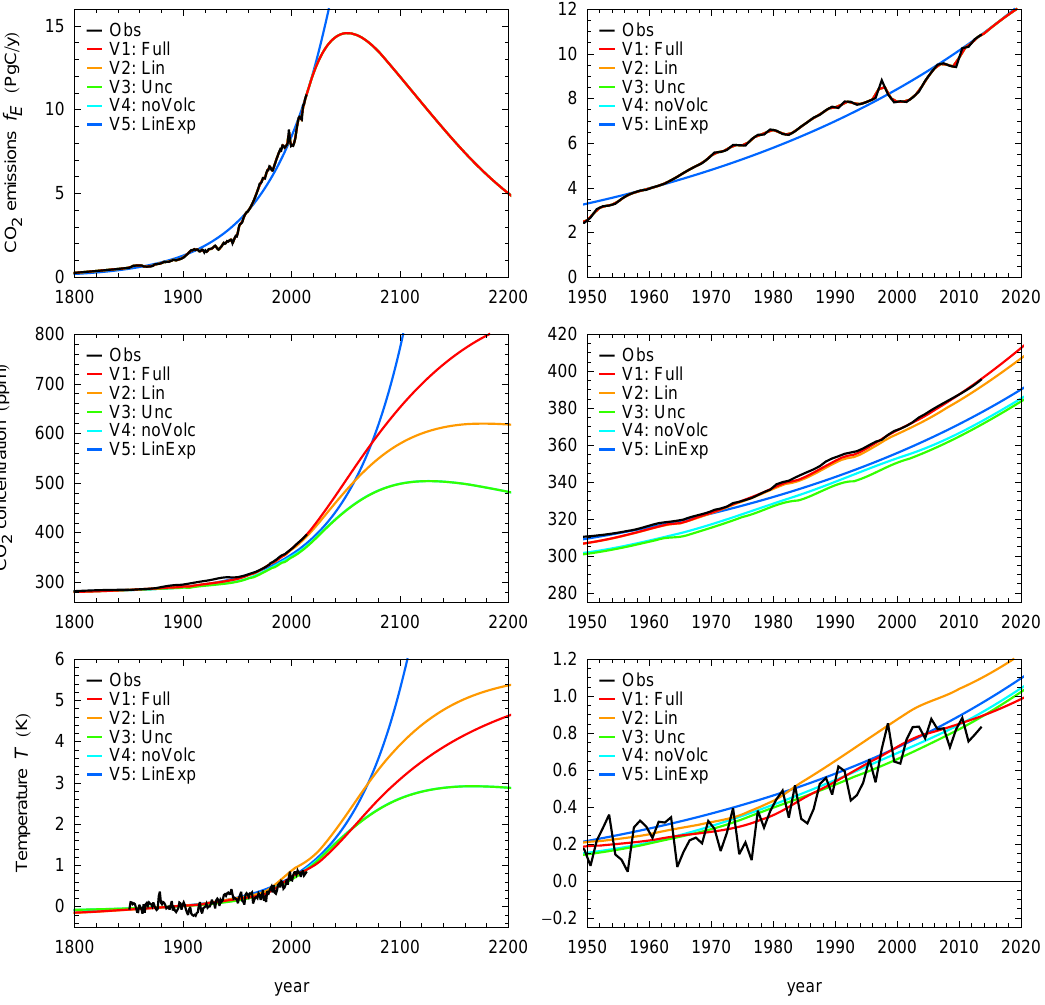
Figure 6. Total CO 2 emissions ( f E , top row) and SCCM predictions for CO 2 concentration (middle row) and temperature (bottom row), at five accumulating levels of model simplification, as in Fig. 3: (1) full model, (2) linearised, (3) uncoupled, (4) no volcanoes, and (5) LinExp idealisation. The emissions scenario is the case Q = 3000PgC in Fig. 4. Other details follow Fig. 4. This figure is a variation with added detail of Fig. 8 in Raupach (2013), using orderings for model simplification steps consistent with this